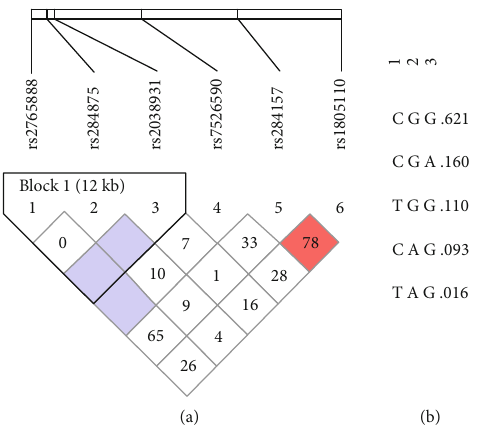
Figure 2: Linkage disequilibrium analysis of rs2765888 ( C > T ), rs284875 ( A > G ), rs2038931 ( G > A ), rs7526590 ( A > T ), rs284157 ( C > T ), and rs1805110 ( G > A ) using the solid spine of LD method. (a) According to HaploView 4.2 color schemes, white corresponds to D ’ < 1 and LOD < 2 , shades of pink/red indicate D ’ < 1 and LOD ≥ 2 , and light blue indicates complete LD with D ’ = 1 and LOD < 2 . (b) Identi fi ed haplotypes and associated frequencies. LOD: Log of odds ratio, a measure of con fi dence in the value of D ’